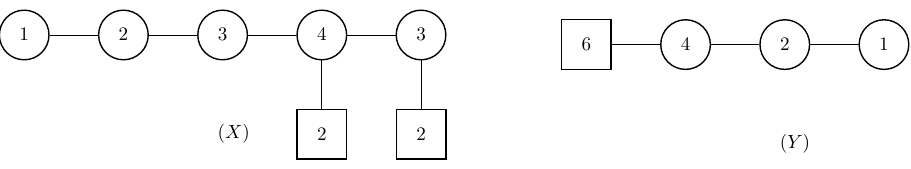
Figure 12 . A pair of mirror dual linear quivers with unitary gauge groups.